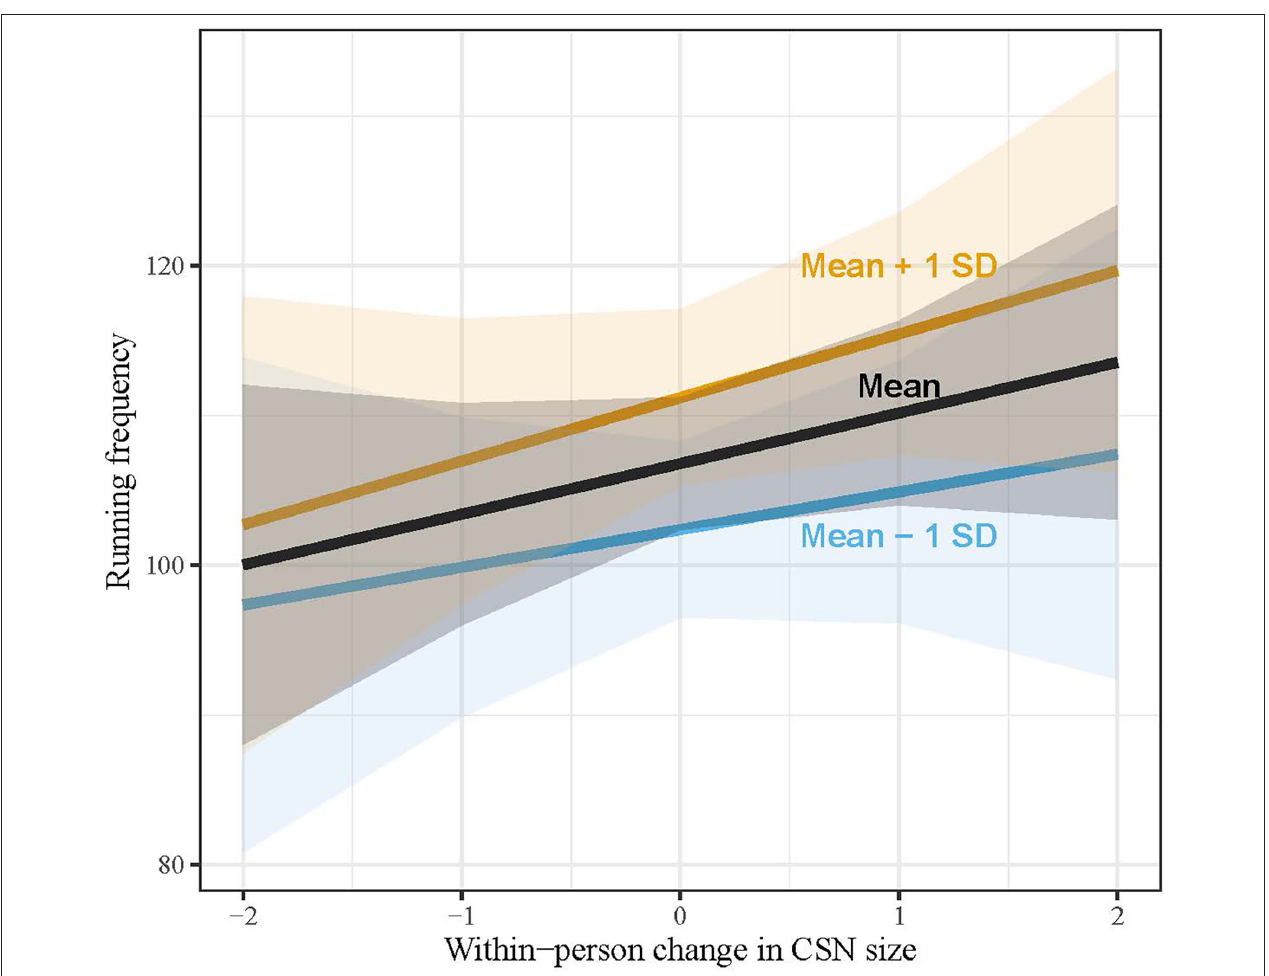
FIGURE 2 | Impact of changes in Core Sports Network (CSN) size on running frequency, moderated by social motivation. Lines reflect predicted values of running frequency for runners with average social motivation, below average (-1 SD), and above average ( shaded areas reflecting 90% confidence intervals. X-axis labels refer to the within-individual changes in CSN size [i.e., deviations from person-specific mean ( x ti